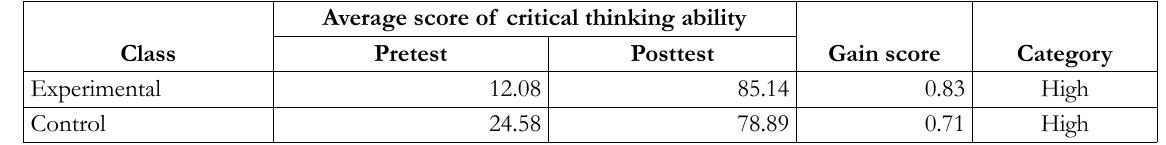
Table 12. Result of critical thinking